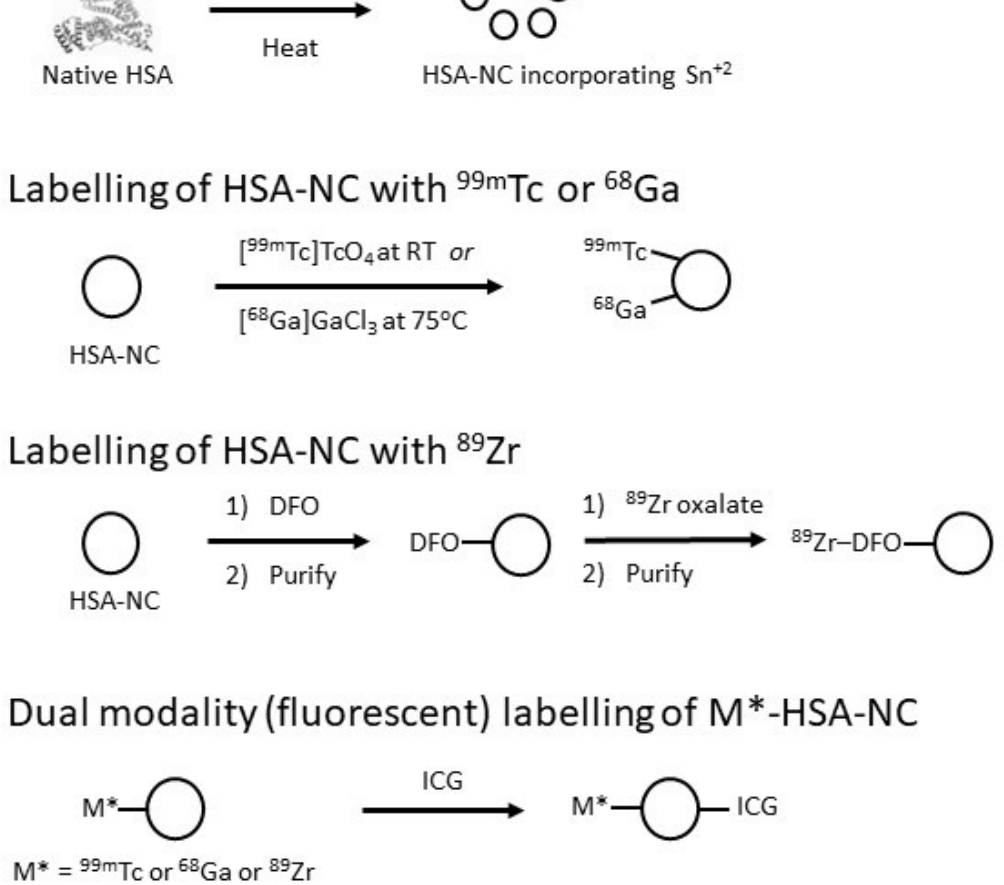
Figure 1. Graphical representation of the sequence of steps in preparation and radiolabelling of HAS-NC and its dual-modality analogue.